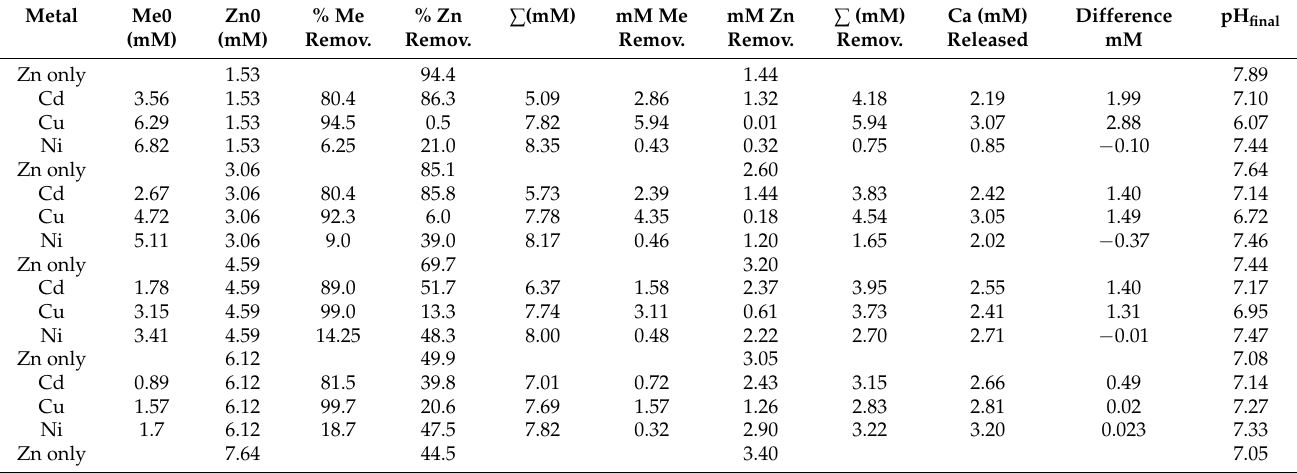
Table 2. Effect of co-ions on the Zn 2+ removal.